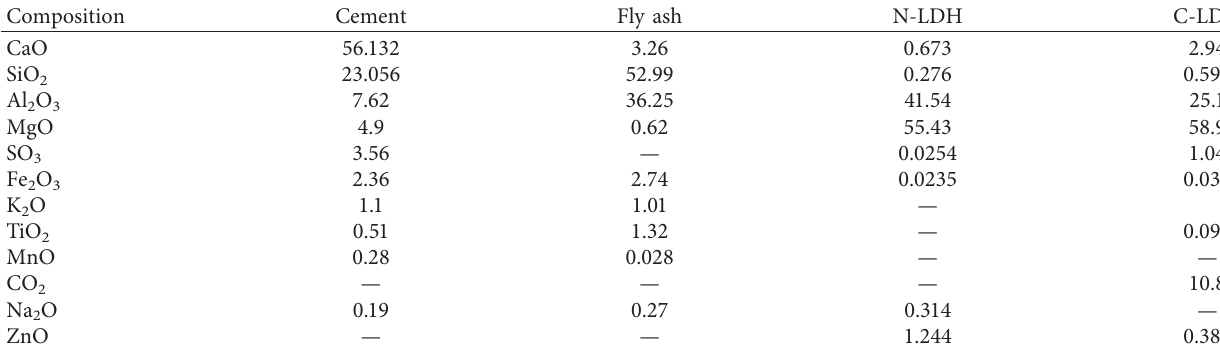
Table 1: Main chemical composition of raw materials (%).